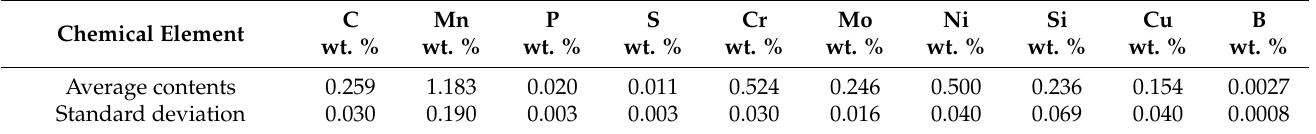
Table 1. Average contents of the chemical composition of the tested steel and its standard deviation.